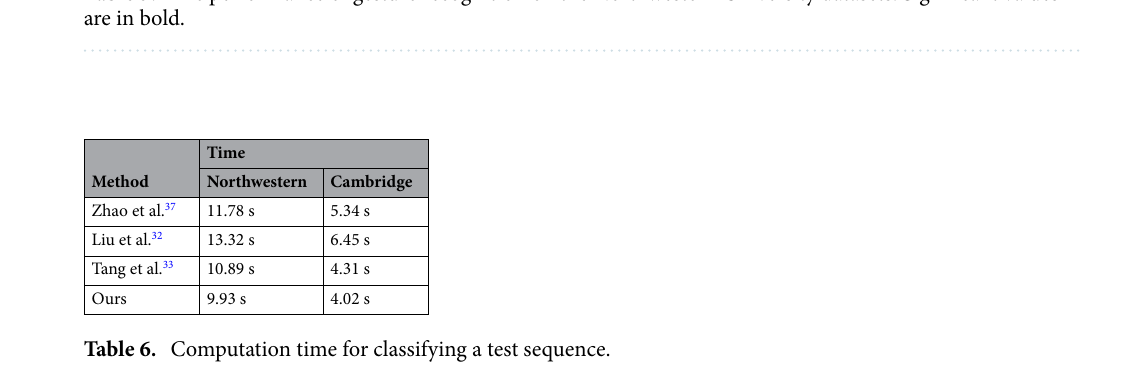
Table 6. Computation time for classifying a test sequence.